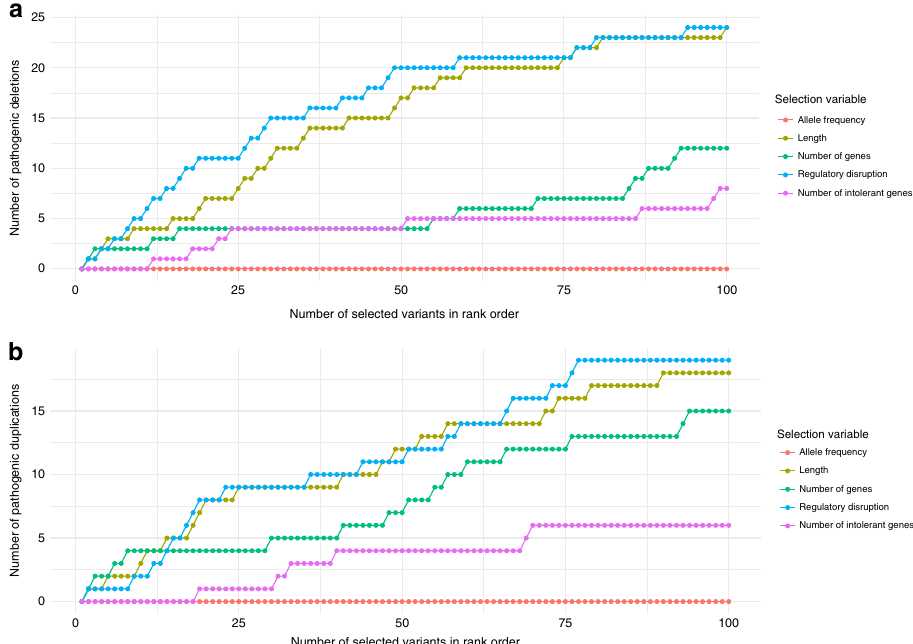
Fig. 6 Regulatory disruption scores prioritize pathogenic CNVs better than standard annotations. Number of pathogenic variants de fi ned as 50% overlap with known pathogenic variant in ClinGen (84 deletions and 84 duplications) identi fi ed based on rank ordering deletions a and duplications b by length (yellow), number of genes deleted (green), number of intolerant genes deleted (purple) allele frequency (red), and regulatory disruption (blue). Where multiple variants had the same value, the order was